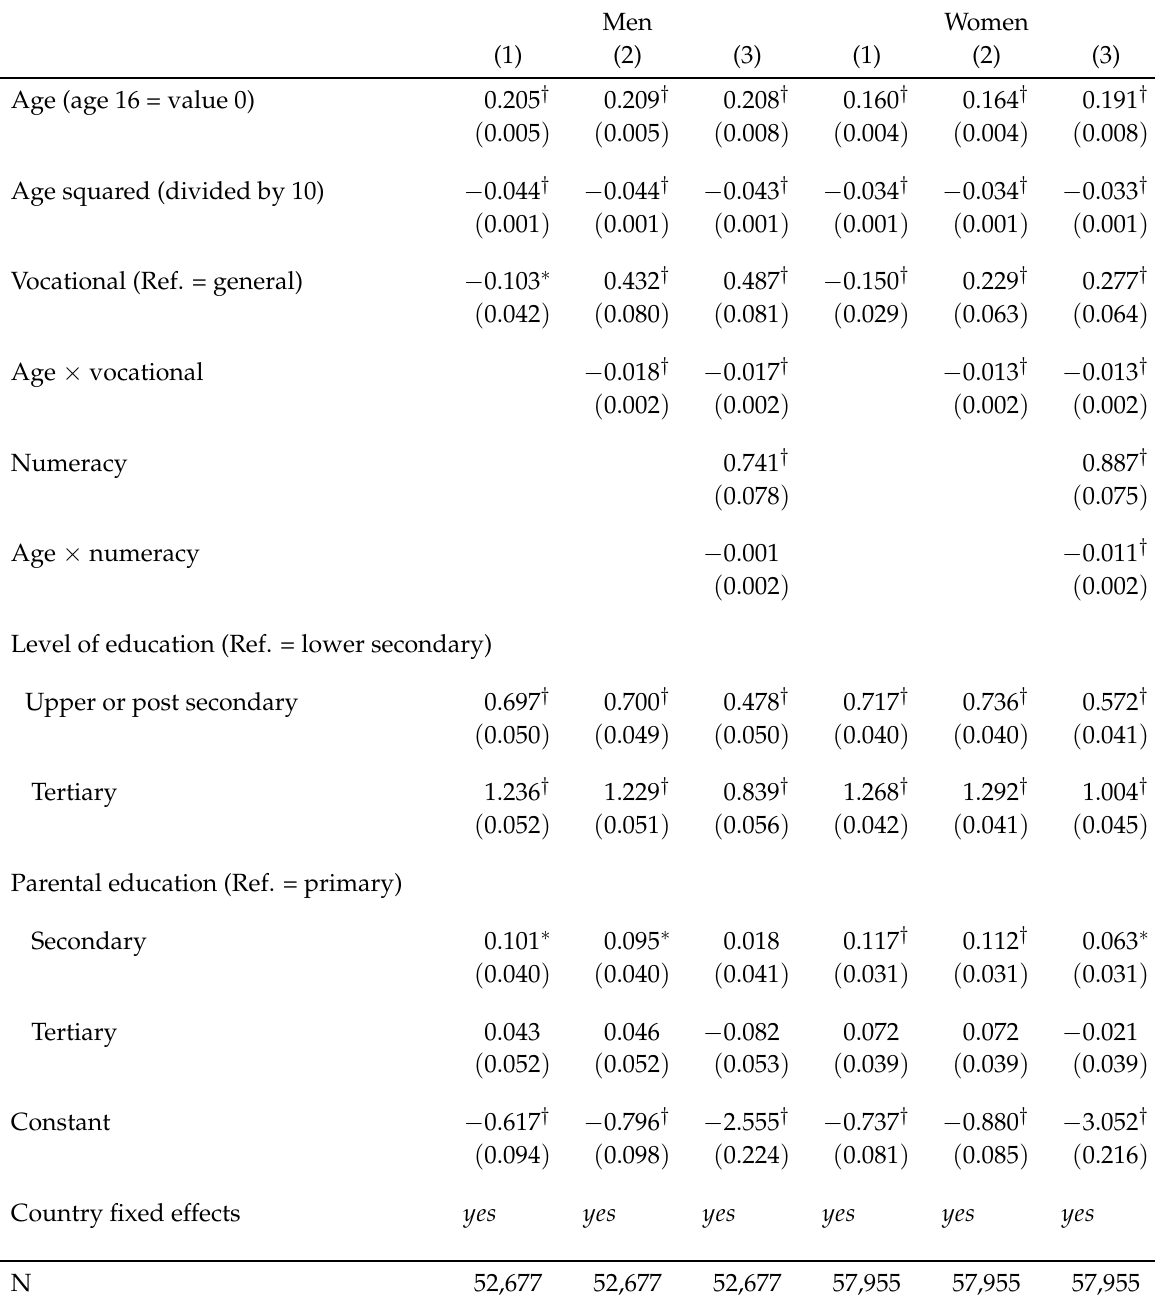
Table 2: Pooled Logistic Regression Models with Country Fixed Effects and Employment as Dependent